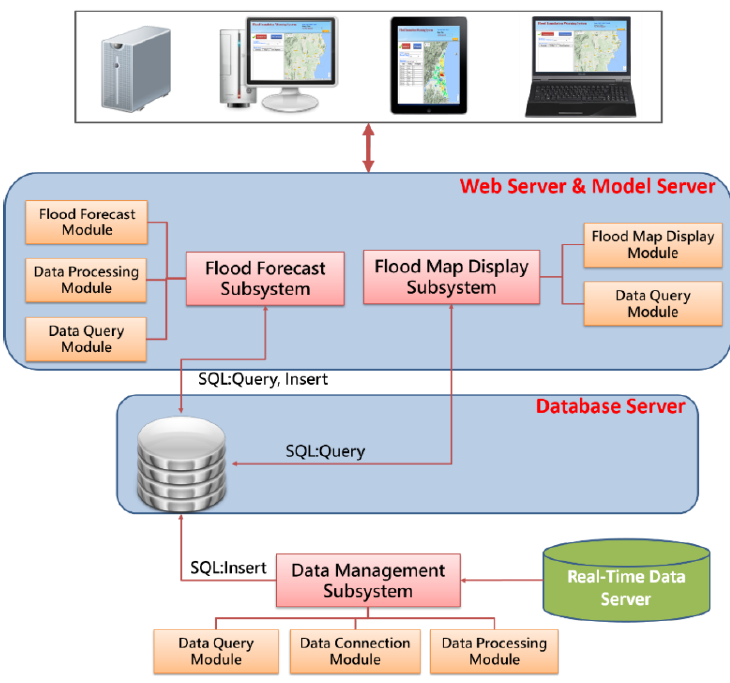
Figure 2. Relationships between four servers, five modules and three sub-systems.